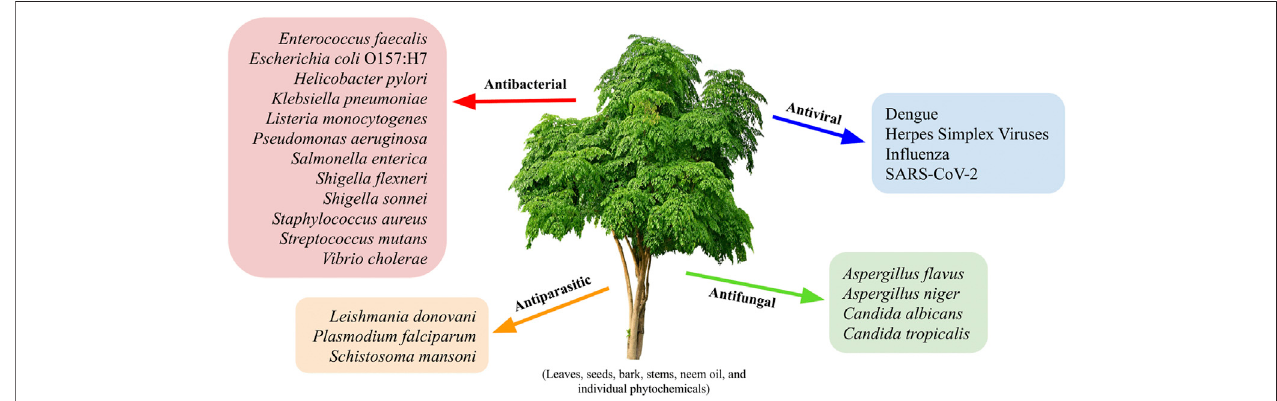
FIGURE1 | Representative antimicrobialtargets ofthe neem tree, Azadirachta indic a. Virtually all parts ofthe neem tree (leaves, seeds, bark, and stems), neem oil, and individual neem-associated phytochemicals have been shown to possess antibacterial, antiviral, antiparasitic, and/or antifungal activities. Some of the pathogens that have been studied and shown to be susceptible to A. indica -associated compounds are listed in their respective categories; the length of the provided list indicates the relative amount of published information on each of the four topics. A more exhaustive list of the pathogens that are susceptible to neem-derived products is available in Supplementary Table S1